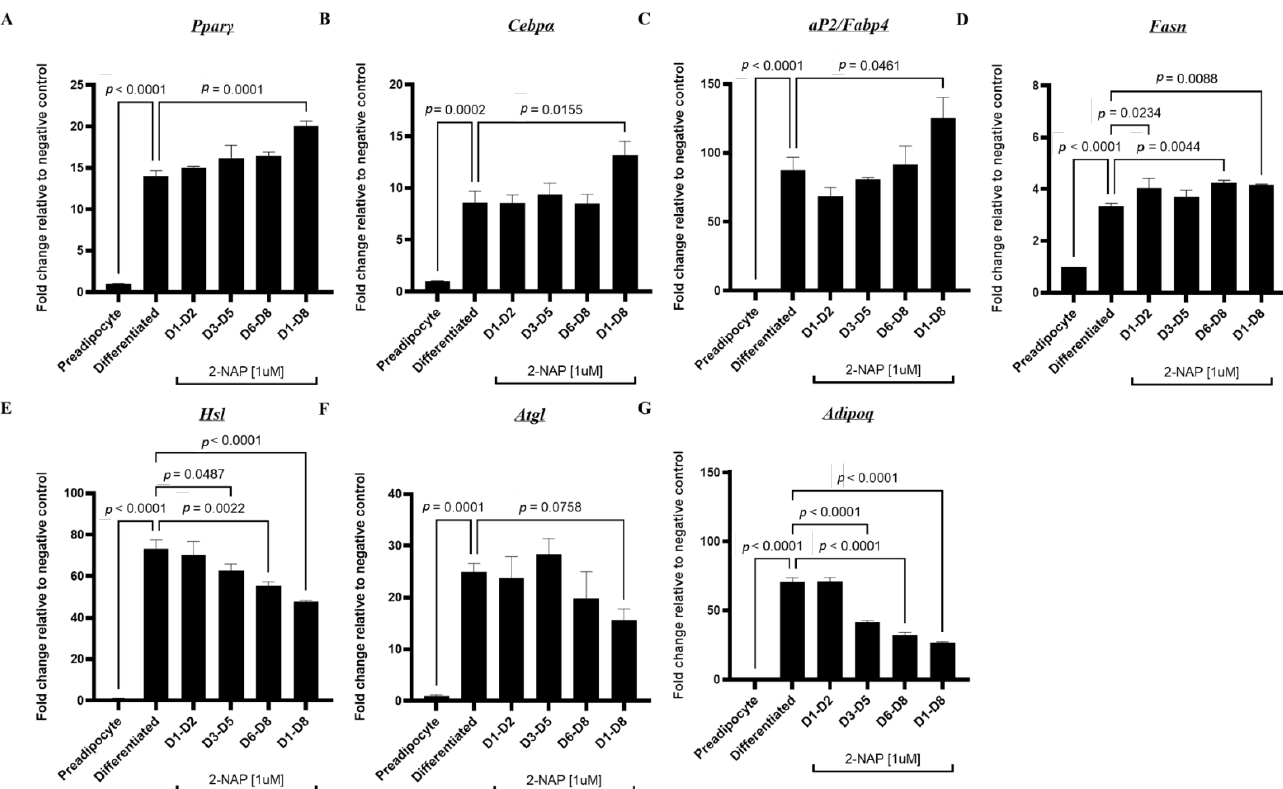
Figure 3. Chronic 2-naphthol treatment regulates adipogenic, lipogenic, and lipolytic gene expression in 3T3-L1 adipocytes. Relative mRNA expression of genes encoding for adipogenic transcription factors ( A ) Ppar γ and ( B ) Cebp α ; adipocyte-specific marker ( C ) ap2/Fabp4, lipogenic and lipolytic markers ( D ) Fasn( E ) Hsl and ( F ) Atgl ; and the adipokine ( G ) Adipoq was measured in preadipocytes and differentiated 3T3-L1 adipocytes treated with 1 µM 2-NAP at different differentiation stages as indicated. Upon experimental termination, mRNA was extracted and relative gene expression was then determined by RT-PCR ( n = 4). The values shown represent the mean ± SEM. A p -value of p < 0.05 indicates statistical significance between two groups.